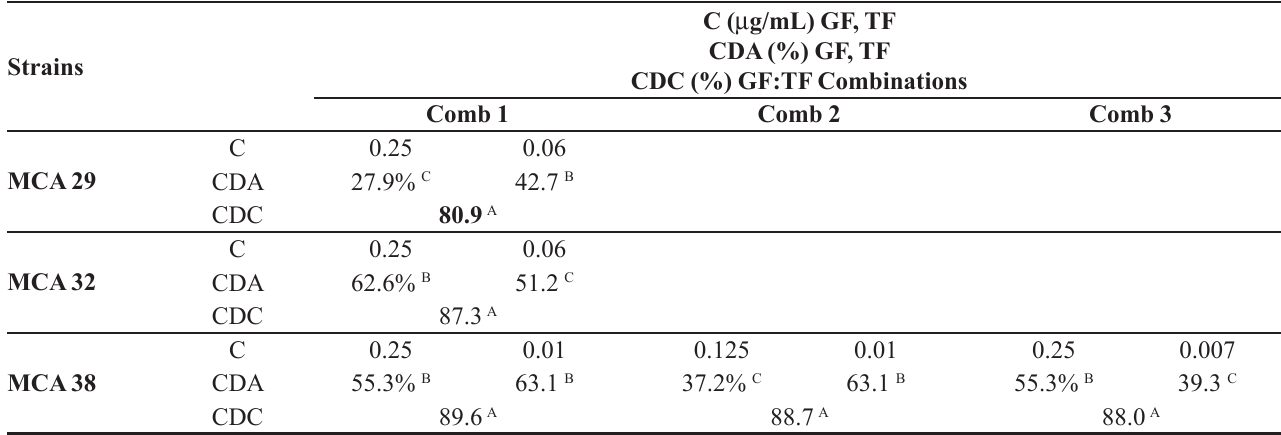
TABLE III - Cell damage after treatment with GF, TF, and GF:TF combinations (quantitative methodology)